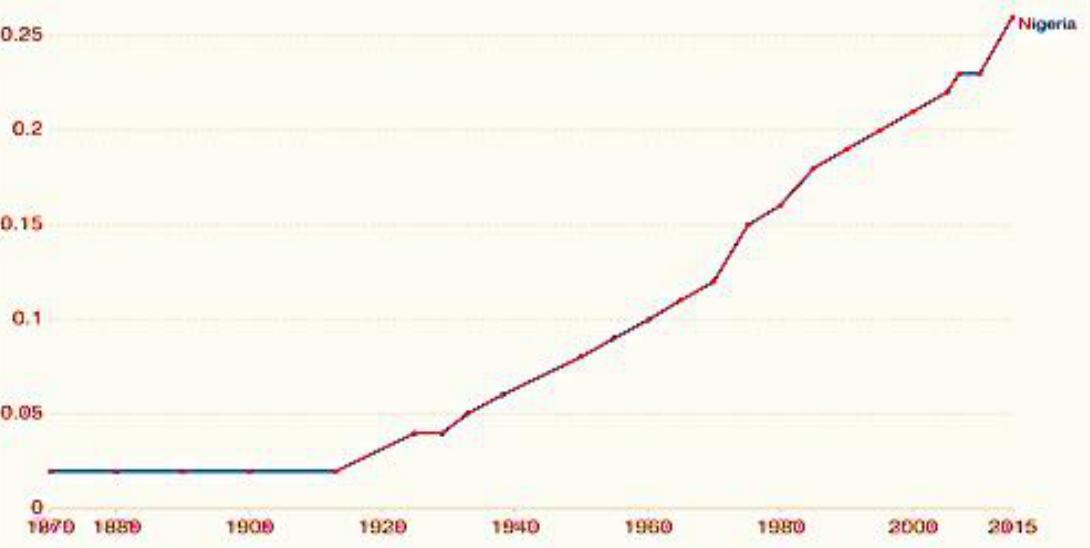
Figure 4. Nigeria's Human Development Index [Historical Index 1870 to 2015]. Source: Author.